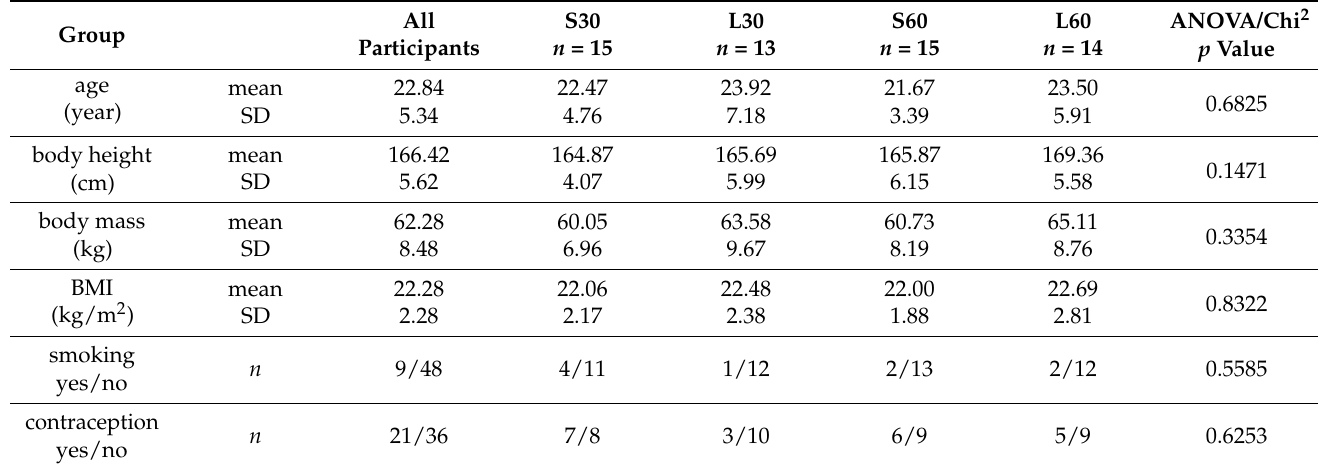
Table 1. Characteristics of the study